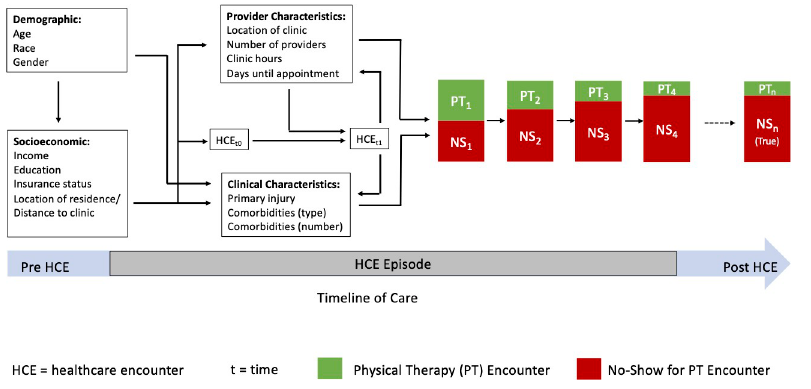
Fig 1. Multi-level factors associated with no-shows in physical therapy